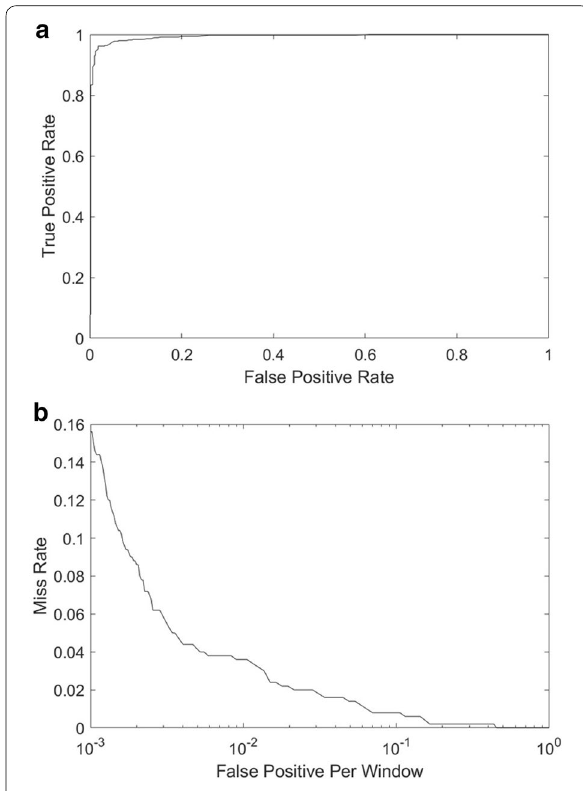
Fig. 5 ROC ( a ) and DET ( b ) curves for HOG detector